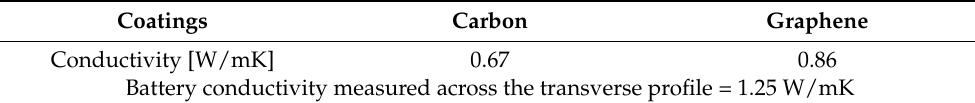
Table 1. Values of conductivity.